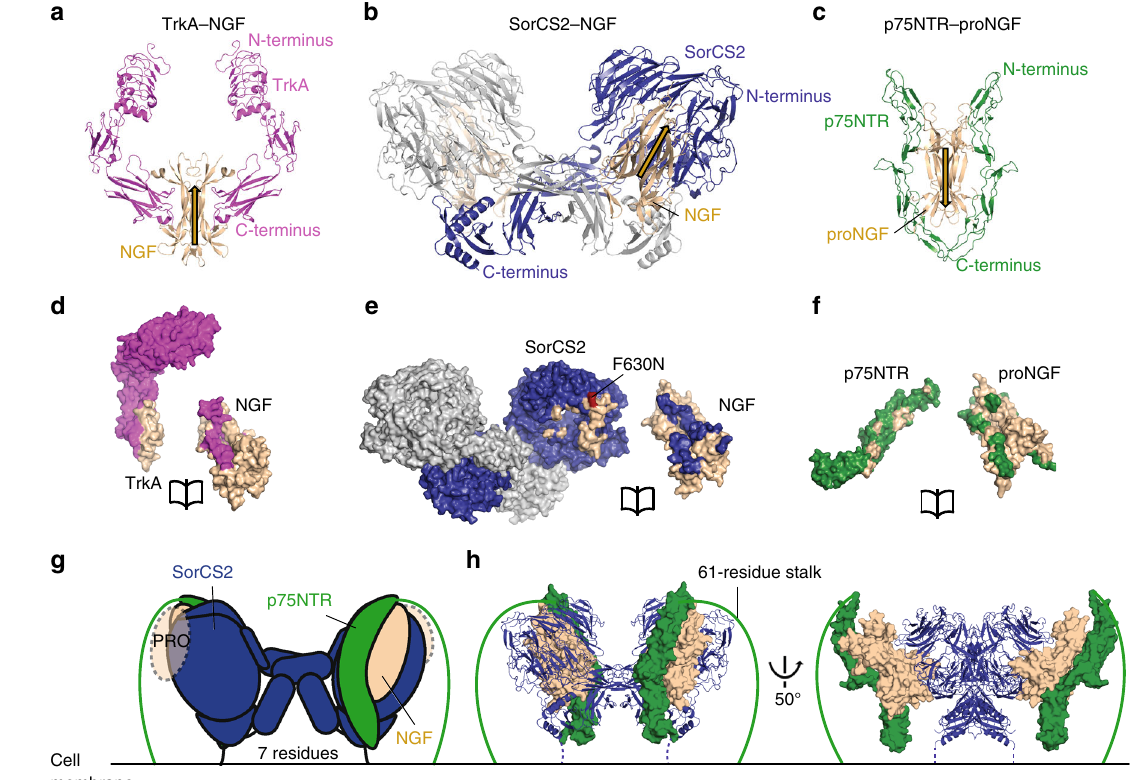
Fig. 6 (pro)NGF complex structures reveal a common receptor binding site on NGF. a – c cartoon representation of NGF (beige) in complex with TrkA ( a , pink) (pdb-id 2IFG) 24 and SorCS2 ( b , blue-gray), and of proNGF (beige) in complex with p75NTR ( c , green) (pdb-id 3IJ2) 12 . The receptors are depicted with their C-termini towards the bottom to indicate their cell-surface attachment side. The direction of (pro)NGF in the complexes is indicated with beige arrows to highlight the reversed direction of proNGF in complex with p75NTR. d – f open-book view of each receptor – ligand interface reveals that the receptor binding site for the three receptors, TrkA ( d ), SorCS2 ( e ), and p75NTR ( f ), all have overlap on the mature part of (pro)NGF. The interface mutant F630N (red) abrogates binding of NGF, proNGF, and proBDNF to SorCS2. g , h Possible model for a ternary SorCS2 – proNGF – p75NTR complex. The proNGF pro domain is shown for clarity but its location and binding site in the complex are unknown. The pro domain does not interact with p75NTR 6 . The orientation of p75NTR is upside down in this model but the connection to the membrane may be bridged by the 61-residue long stalk. Domain representation scheme of the ternary model with SorCS2 in blue, the mature part of proNGF in beige, and p75NTR in green ( g ). Cartoon representation of the ternary complex model with coloring as in ( g ), the mature part of proNGF and the ligand binding segment of p75NTR (pdb-id 1SG1) in surface representation and the 61-residue p75NTR stalk represented by a line ( h